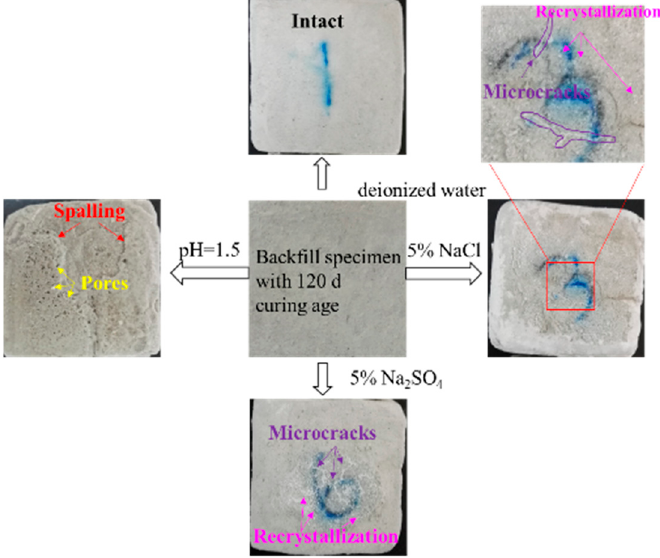
Figure 3. Visual inspection of the PG-based backfill specimens with different exposure solutions after 30 drying-wetting cycles.